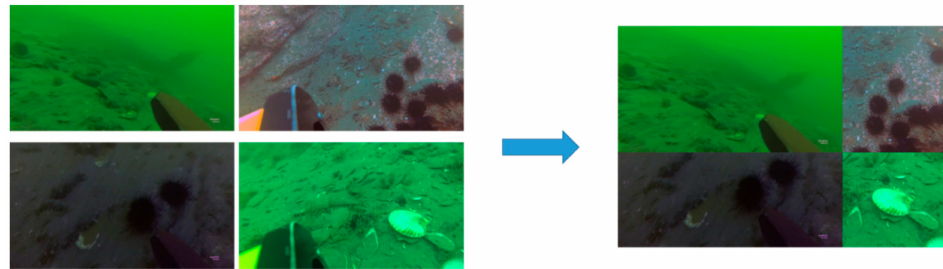
Figure 4. E-mosaic